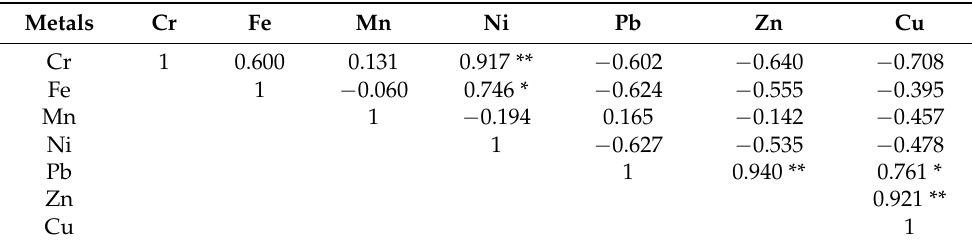
Table 8. Correlation matrix of metals in the